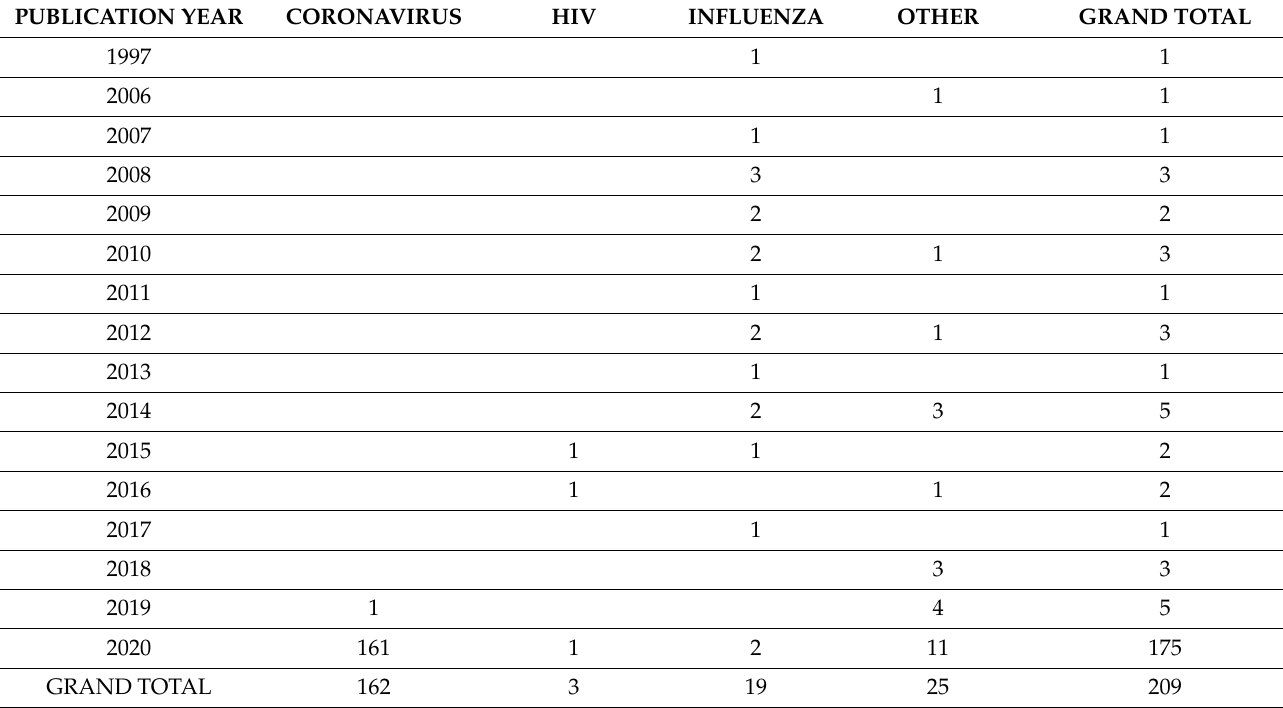
Table 7. Research Articles by Virus Type.